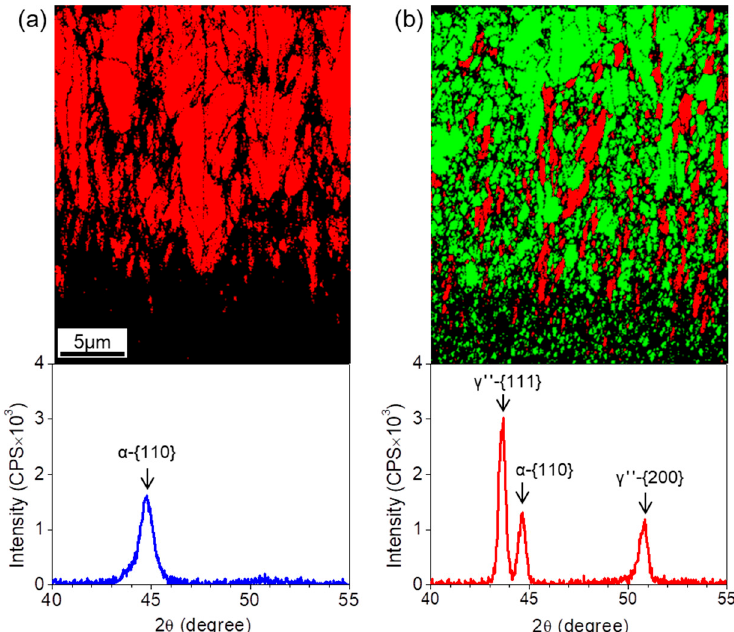
Figure 3. The α → γ″ phase transition in the electroformed Fe-35 wt % Ni alloy. ( a ) EBSD maps and XRD measurements show that in the as-deposited state, the single α phase consists of nanometer-sized crystallites (dark area) in the initially deposited section of the sample up to approximately 5 μ m from the D-surface and a columnar type of large-sized grains (red-colored area) developed in the other section. ( b ) During annealing at 703 K for 30 min, both columnar and nanostructured grains of the α phase are transformed into the γ″ phase (green-colored area).